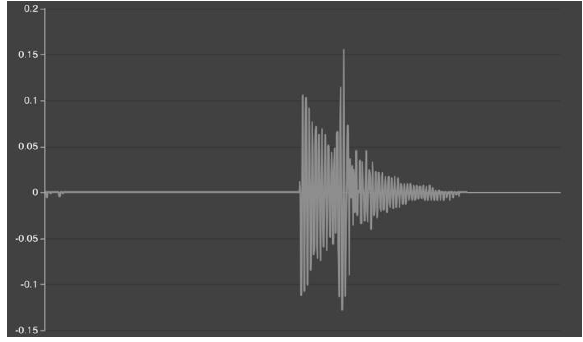
Figure 11. Amplitude over time